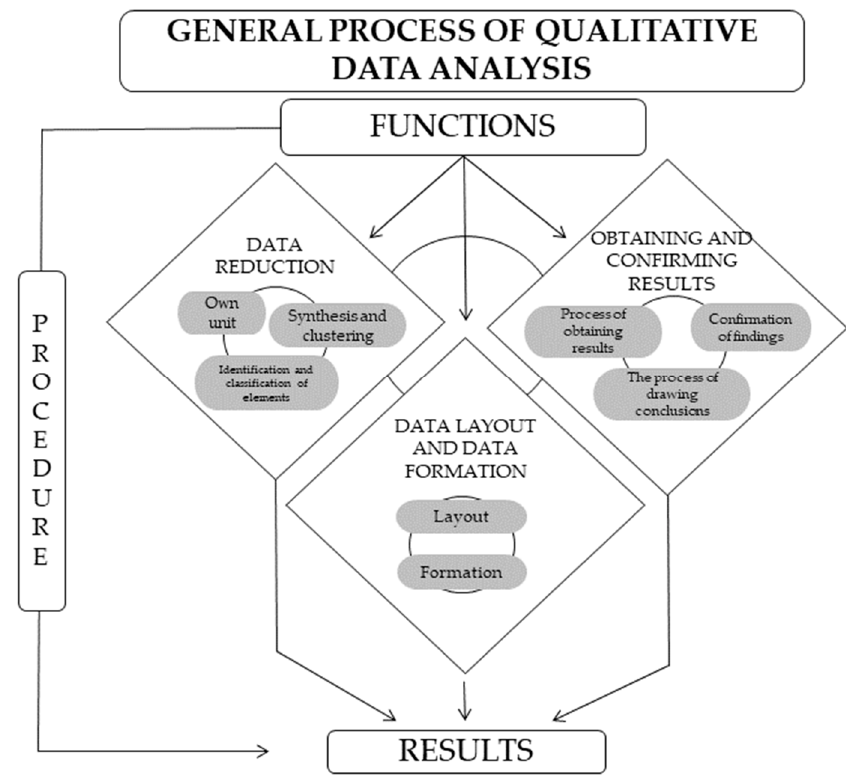
Table 2. Categorical system and number of references. Emerging Dimension Category Subcategory Rec No. Ref.